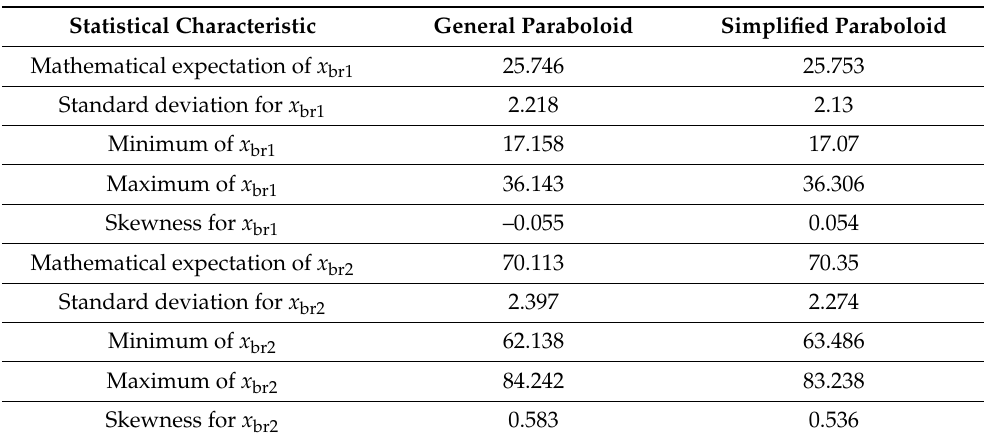
Table 4. Numerical characteristics of breakpoint abscissas